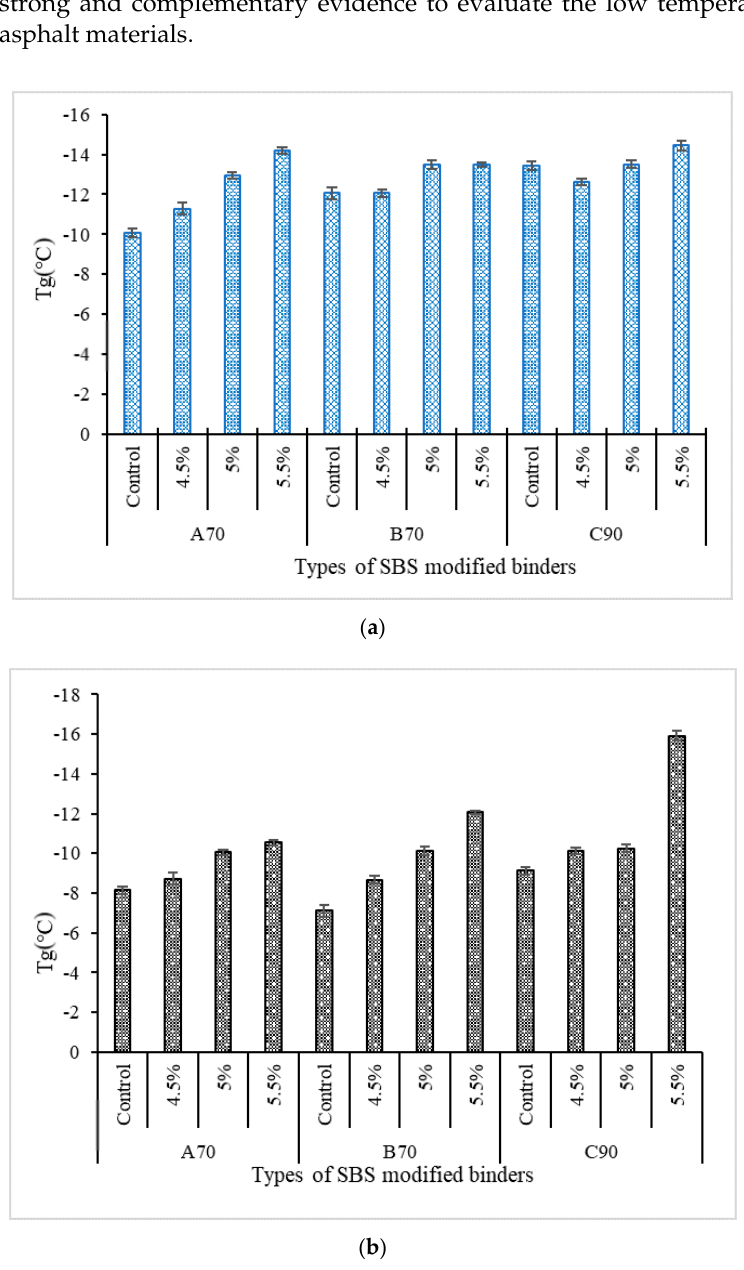
Figure 5. Fitting results of different SBS modified asphalts: ( a ) unaged state; ( b ) PAV state.